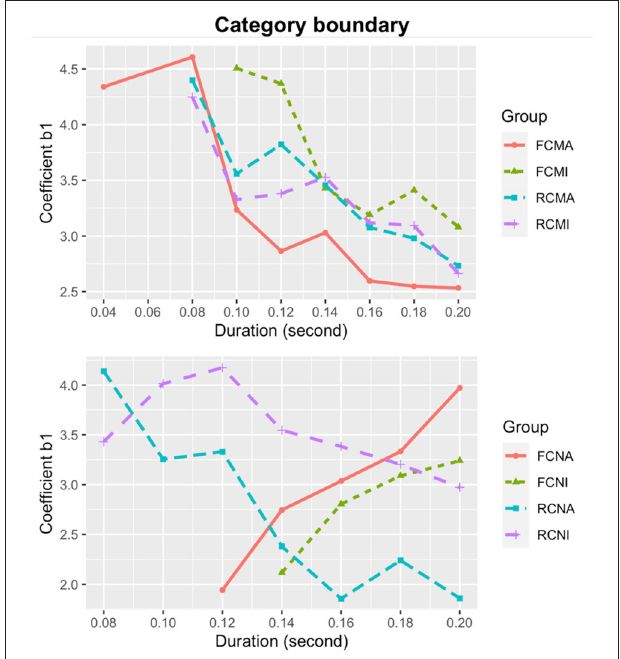
FIGURE 5 | Category boundary for Cantonese musicians and non-musicians. The upper figure shows the category boundary of the musician group and the lower one stands for that of the non-musician